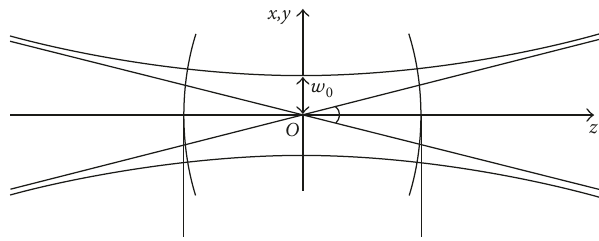
Figure 1: Geometry of coordinate of the incident Gaussian beam. Table 1: Scattering cross section of sphere particle with the different position ( r